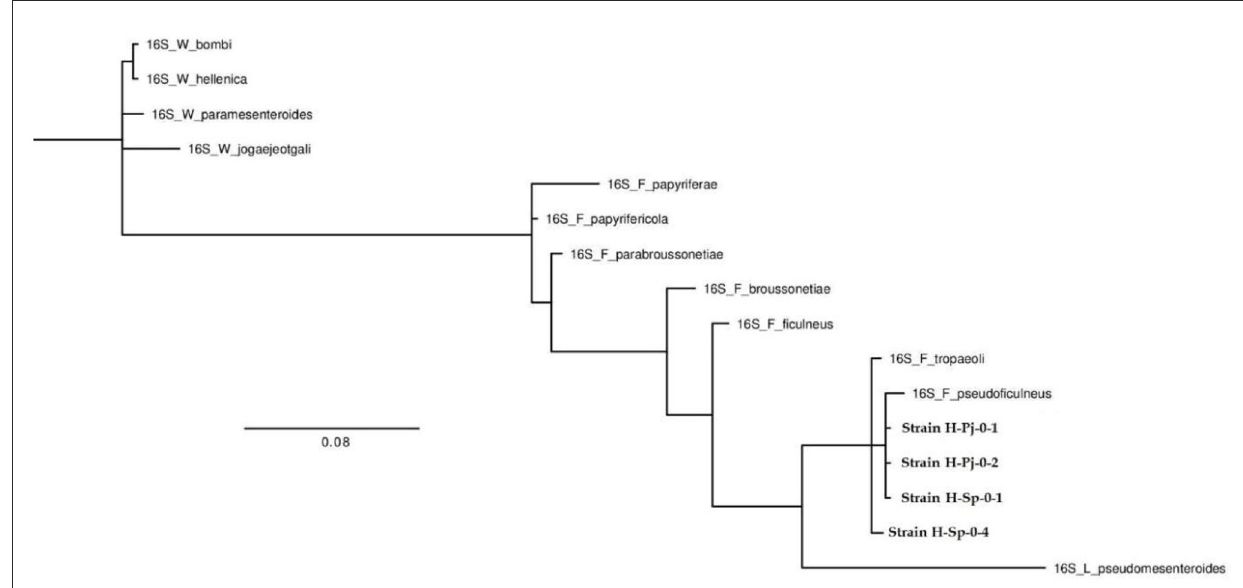
FIGURE4 Phylogenetic tree of the strains found in honey belonging to the genus Fructobacillus (H-Pj-01, H-Pj-02, H-Sp-01, and H-Sp-04).